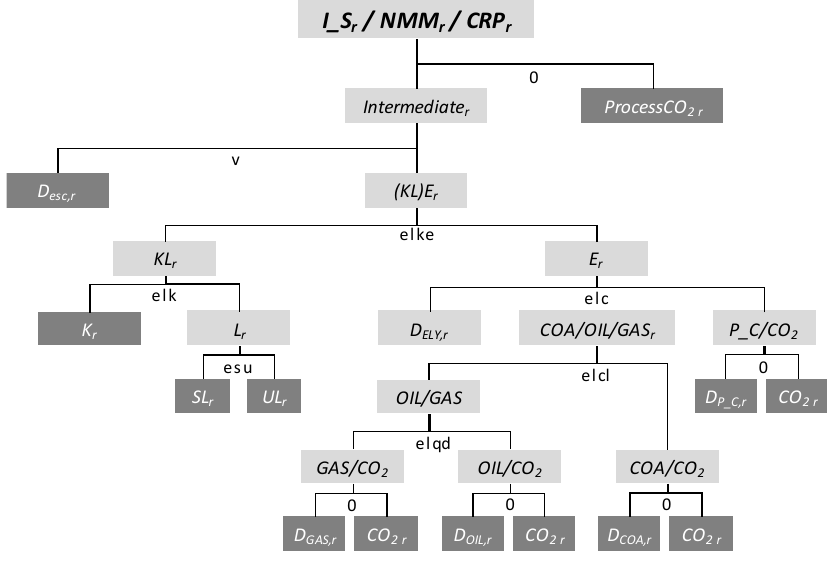
Figure A2. Nesting structure of non-resource using sectors with combustion and process emissions in production in the CGE model.